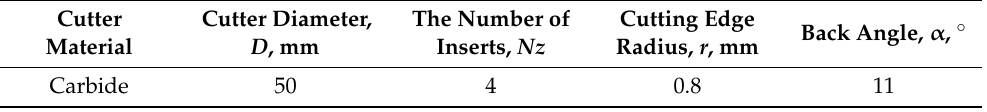
Table 2. Cutting tool parameters.